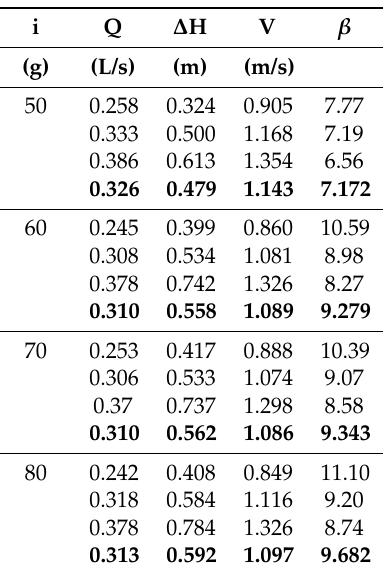
trend for 60 and 70 g: (cid:2010) (cid:3404) 10.37 V (cid:2870) (cid:3398) 27.51 V (cid:3397) 26.98 .